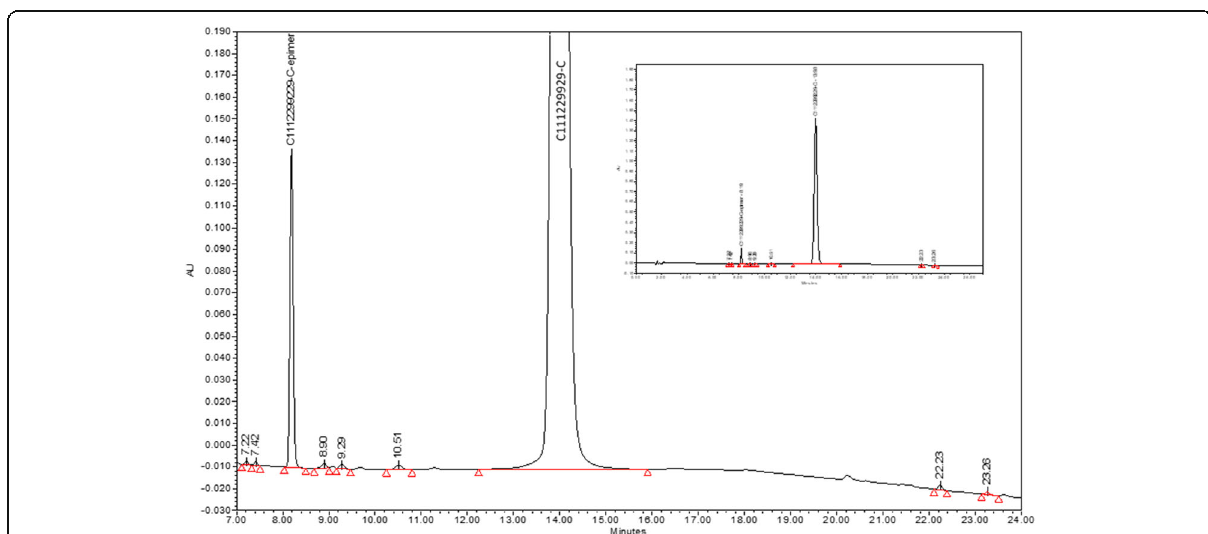
Fig. 1 A representative chromatogram under nominal